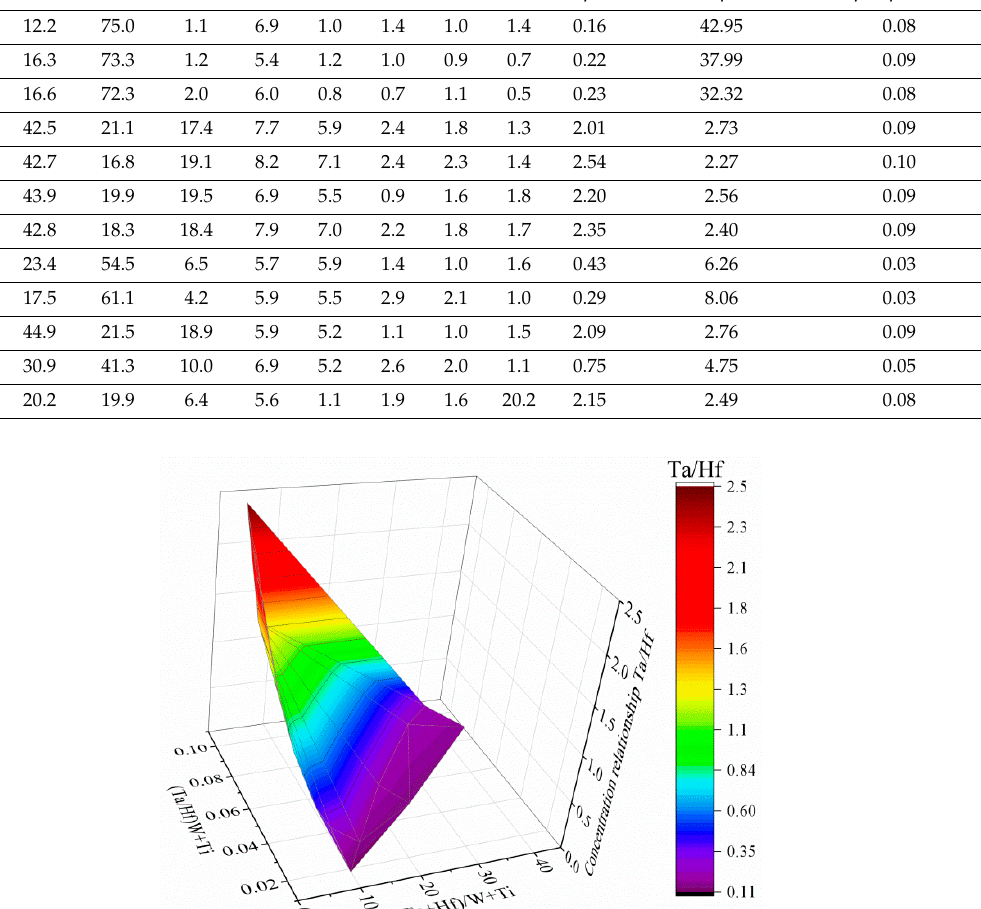
Figure 8. Graphical representation of selected concentration relationships between alloying elements in carbides. Based on the SEM-EDX point